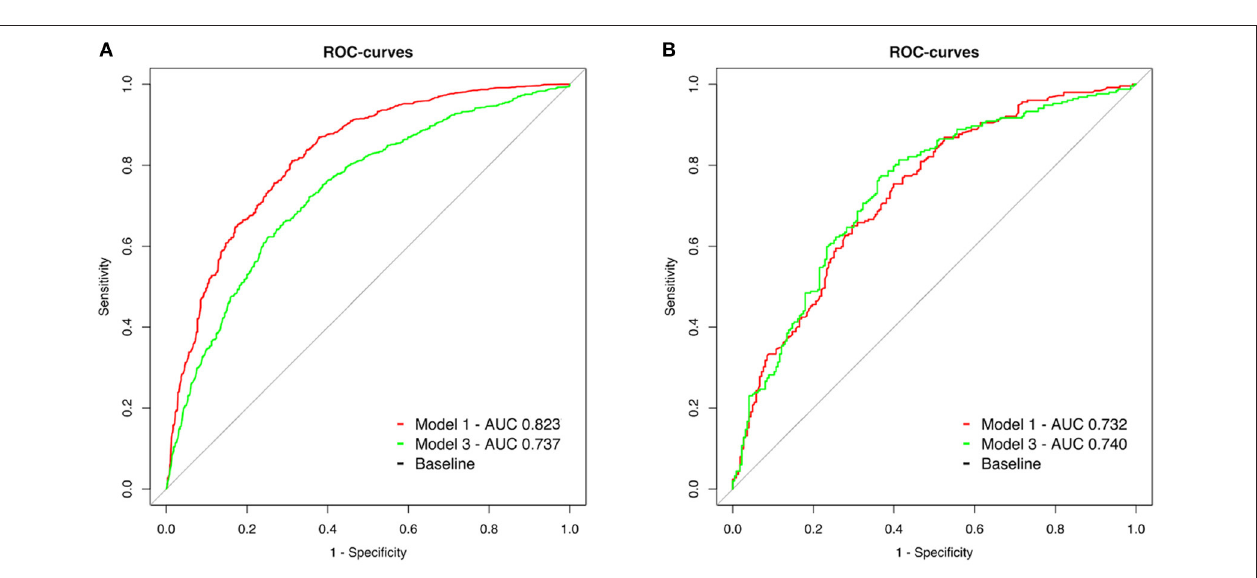
FIGURE 3 | (A,B) Receiver operating characteristic (ROC) curves of two models to predict 30-day neurological outcome. Model 1 (red line): Inclusion of peri-arrest factors (age, sex, witness status, BLS, shockable initial rhythm, and cumulative adrenaline). Model 3 (green line): Metabolic parameters from the initial blood gas analysis (pH, lactate level, and base